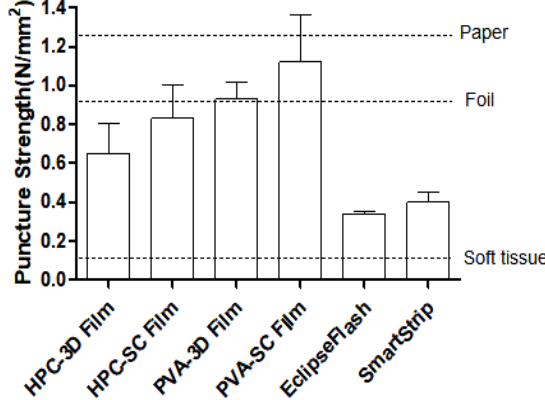
Figure 4. Puncture strength of the marketed products and film samples (dashed lines represent the reference materials).